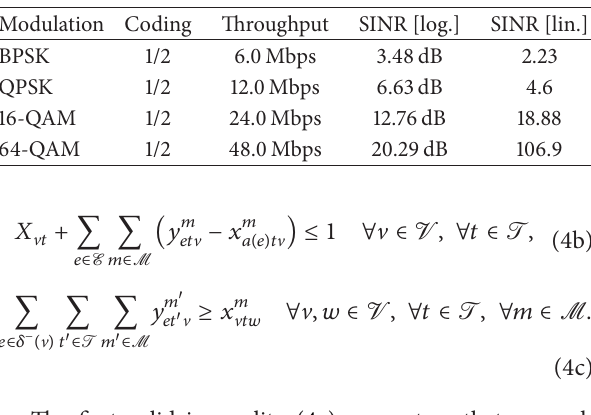
Table 1: Modulation and coding schemes. Table 2: Considered network